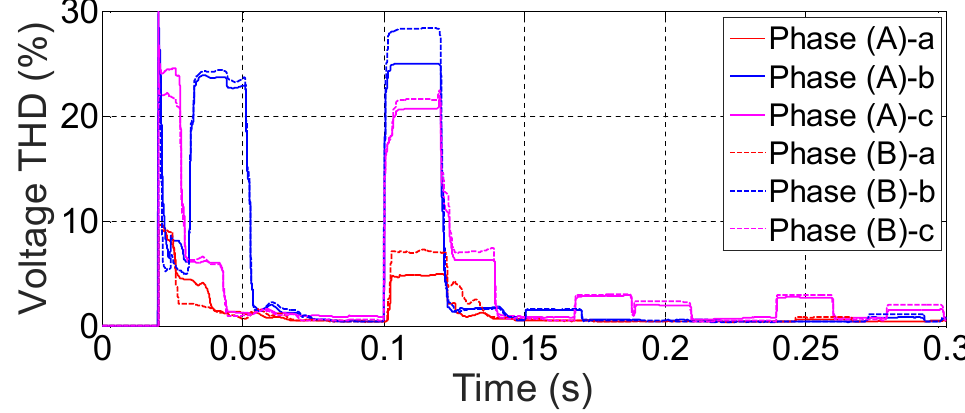
Figure 11. Voltage THD per phase and microgrid in mode interconnected and